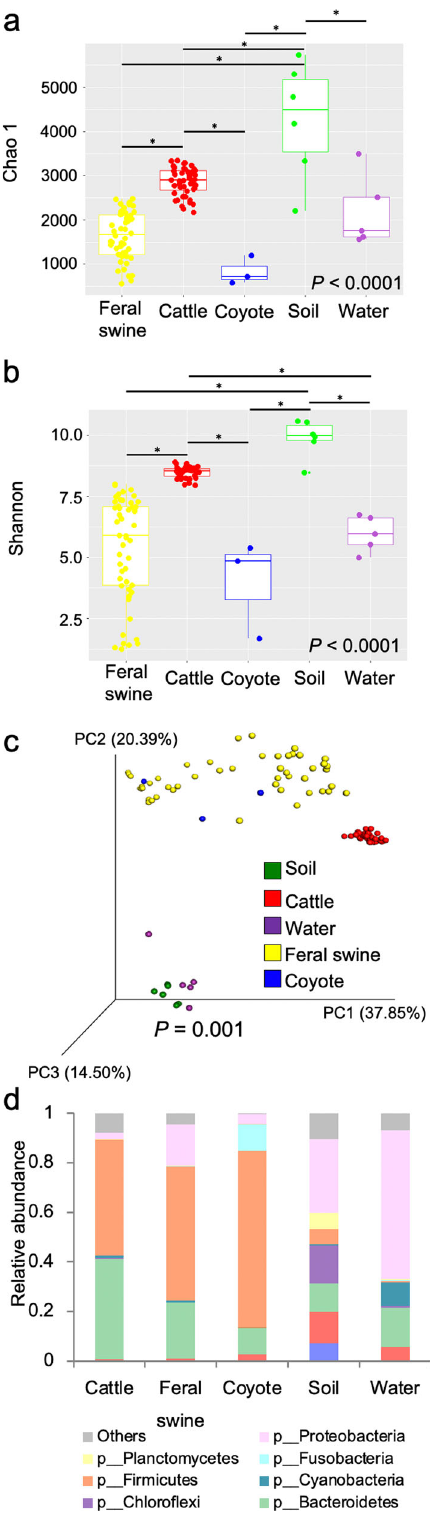
Fig. 3 Microbiota structure in animal feces and environmental samples. a Bacterial richness of cattle, wildlife, and environmental samples. b Bacterial diversity of cattle, wildlife, and environmental samples. Box plots display the median (center line), 25th and 75th percentiles (box) and 5th and 95th percentiles (whiskers) for each individual. Asterisks indicate a statistical difference ( P < 0.05) of each category comparison. c The principal coordinate analysis (PCoA) plot based on weighted UniFrac distances. PCoA plots demonstrated distinct microbiota structure of cattle, wildlife, and environmental samples ( P = 0.001). d The relative abundance of bacteria in cattle, wildlife, and environmental samples at the phylum taxonomic